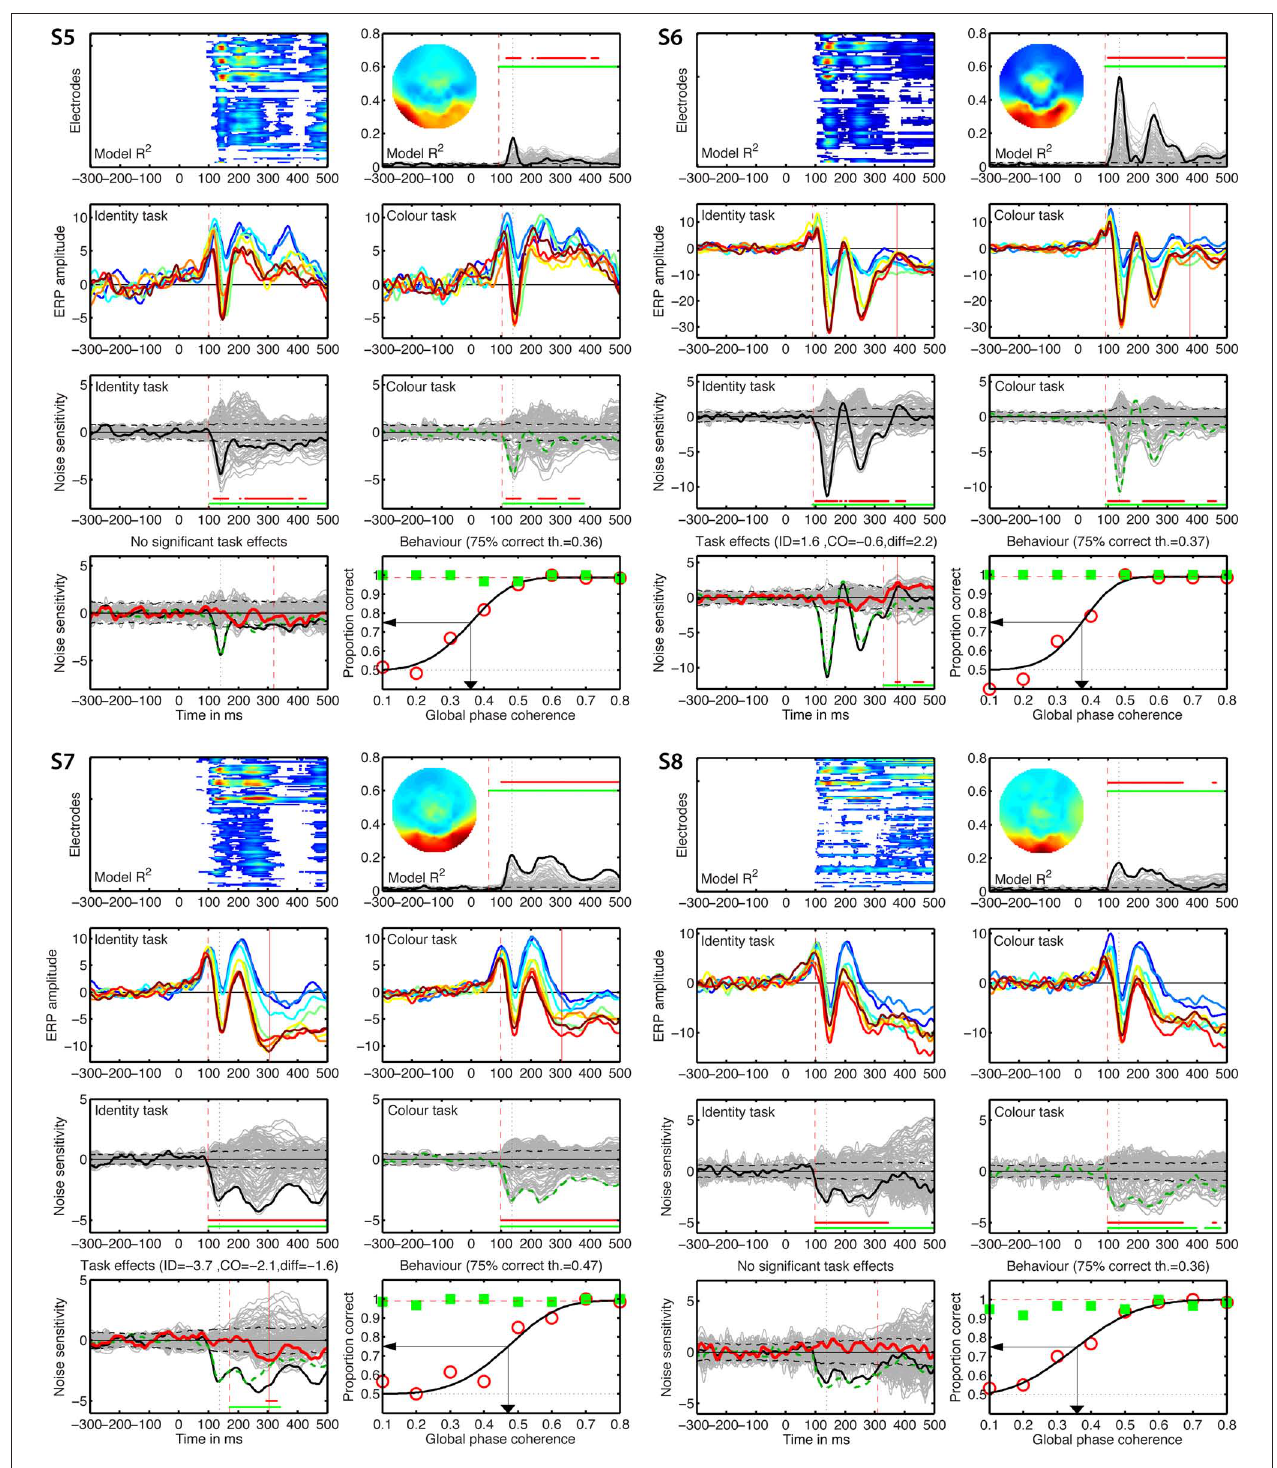
FiGuRE 6 | individual results for subjects S 5– S 8. See Figure 5 caption for details.